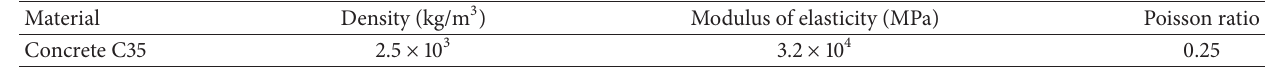
Table 7: Physical and mechanical parameters of